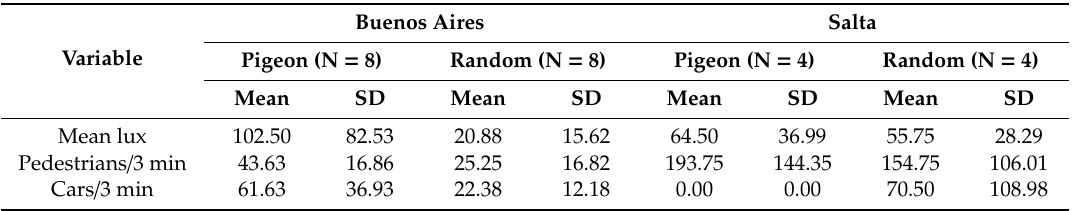
Table 2. Description of environmental variables in sites with presence of foraging pigeons and random sites in Buenos Aires and Salta, Argentina. N: number of sites surveyed, SD: Standard deviation. Buenos Variable